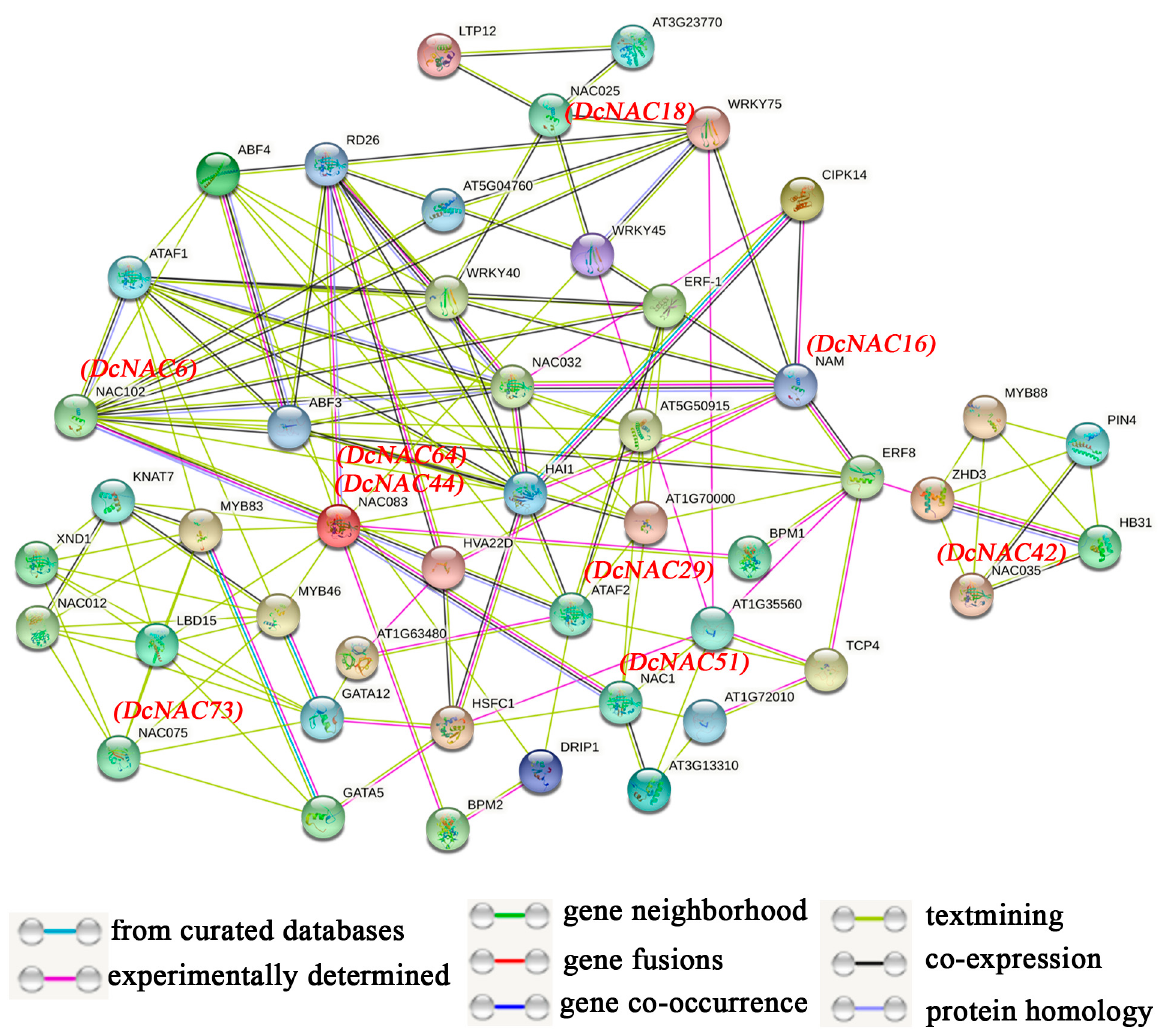
Figure 8. Interaction networks of the selected DcNACs in D. catenatum and related genes in Arabidopsis . The colored, white, empty, and filled nodes represent the first shell of interactors, the second shell of interactors, proteins with unknown 3D structure, and proteins with known or predicted 3D structure, respectively. The light blue and purple lines indicate known interactions. The green, red, and blue lines indicate predicated interactions. The cyan, black, and yellow lines represent protein homology, co-expression, and text mining, respectively.